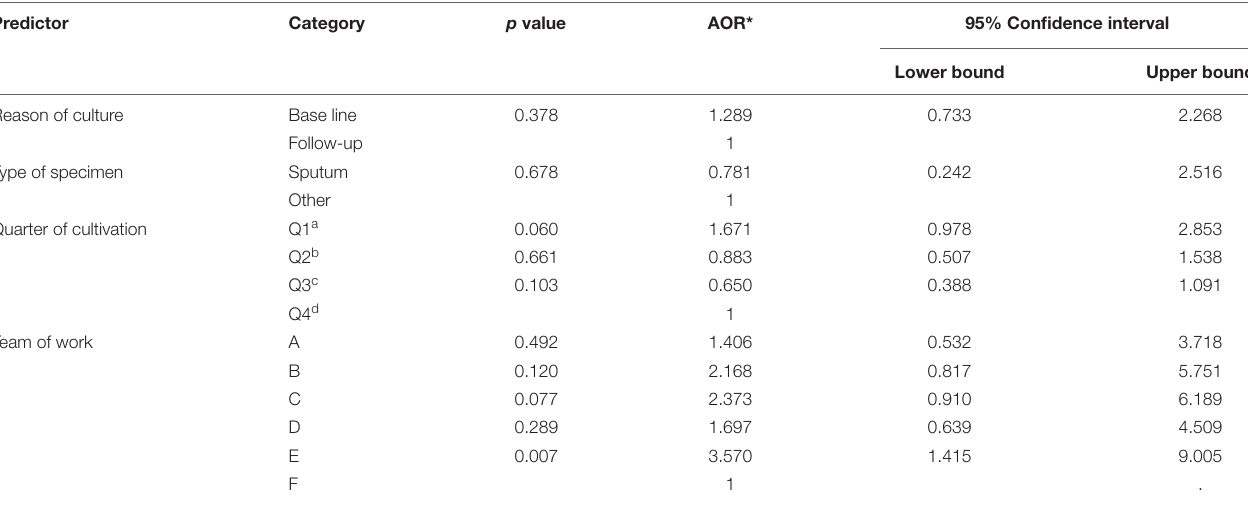
TABLE 3 | Multivariate logistic regression of single tube contamination.